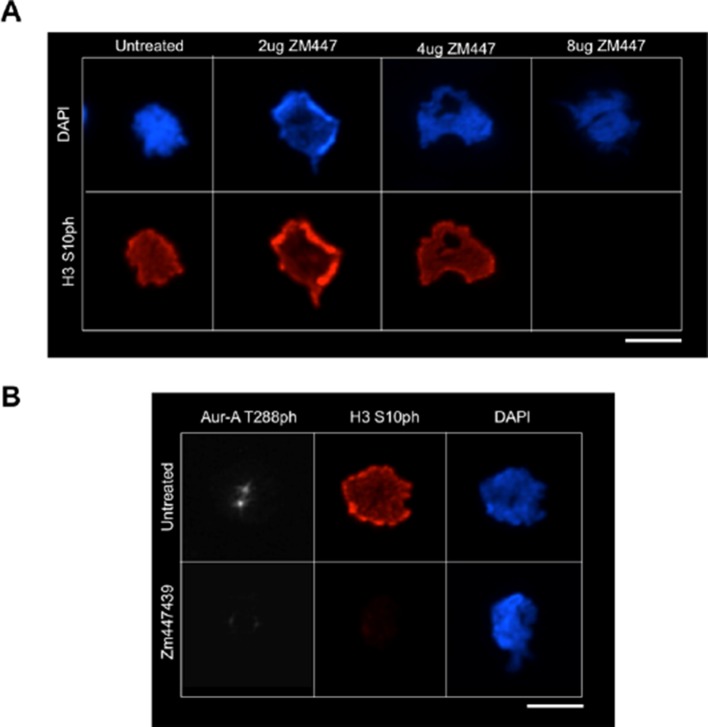
DOI:
http://dx.doi.org/10.7554/eLife.11402.027